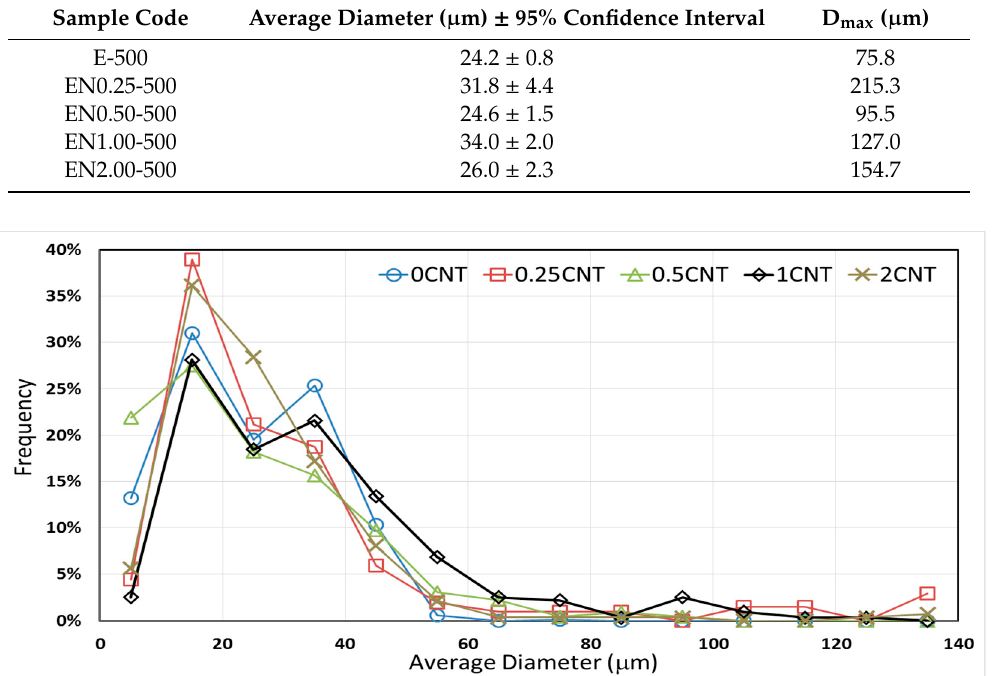
Figure 7. Size distribution of microcapsules prepared with different CNT contents at 500 rpm mixing speed. Table 5. Effect of CNT content on average and maximum microcapsule diameters.